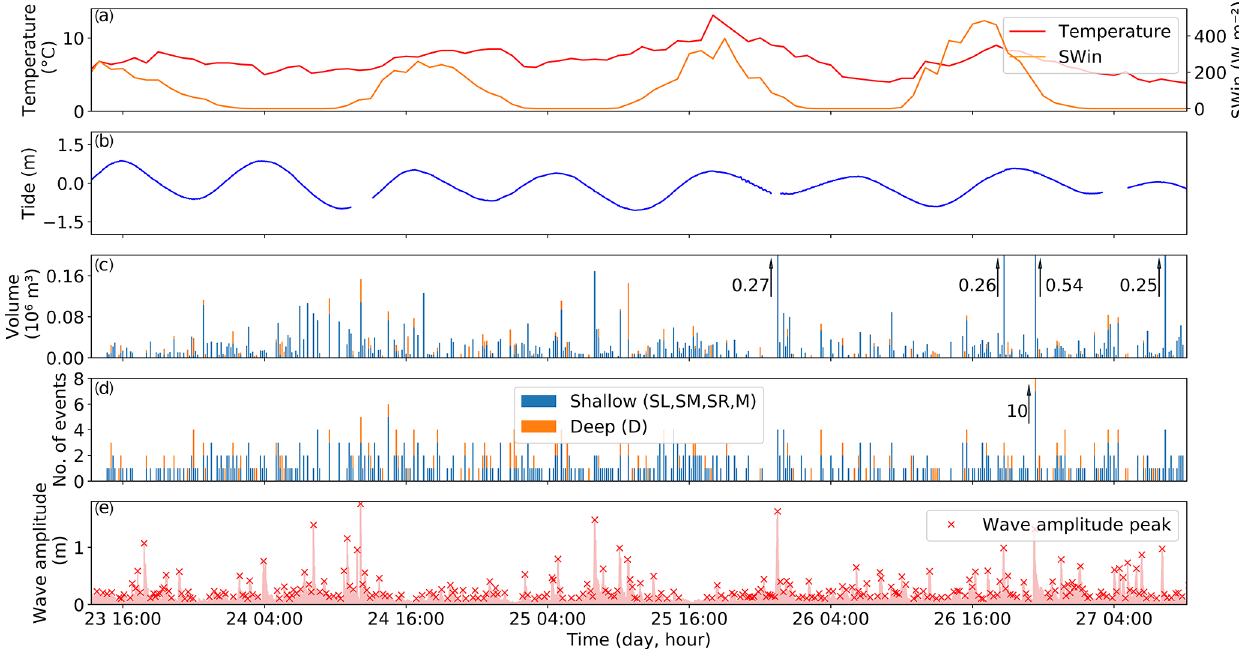
Figure 12. Comparison between forcing and detected calving during a 3d period. (a) Air temperature and incoming shortwave radiation from the AWS1. (b) Tides in metres. (c) Volume of calving events in cubic metres for the shallow and deep sectors. (d) Number of calving events. The calving events in the deep sector are plotted above those in the shallow sector. (e) Pressure-sensor-derived wave amplitudes and detected